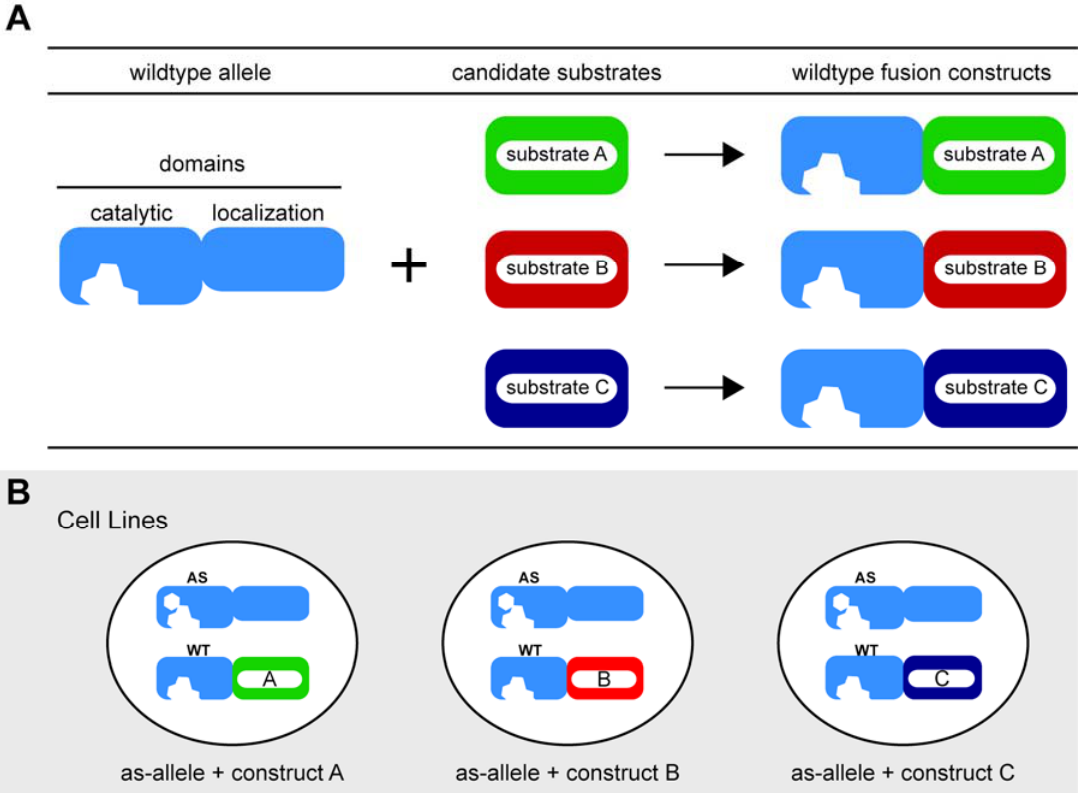
Figure 3. Chemical genetic complementation strategy to probe for functional kinase-substrate relationships. ( A ) Fusion constructs are generated by replacing the localization domain of the wildtype (WT) allele with candidate substrates; ( B ) Fusion constructs are introduced into cells expressing the analog-sensitive (AS)